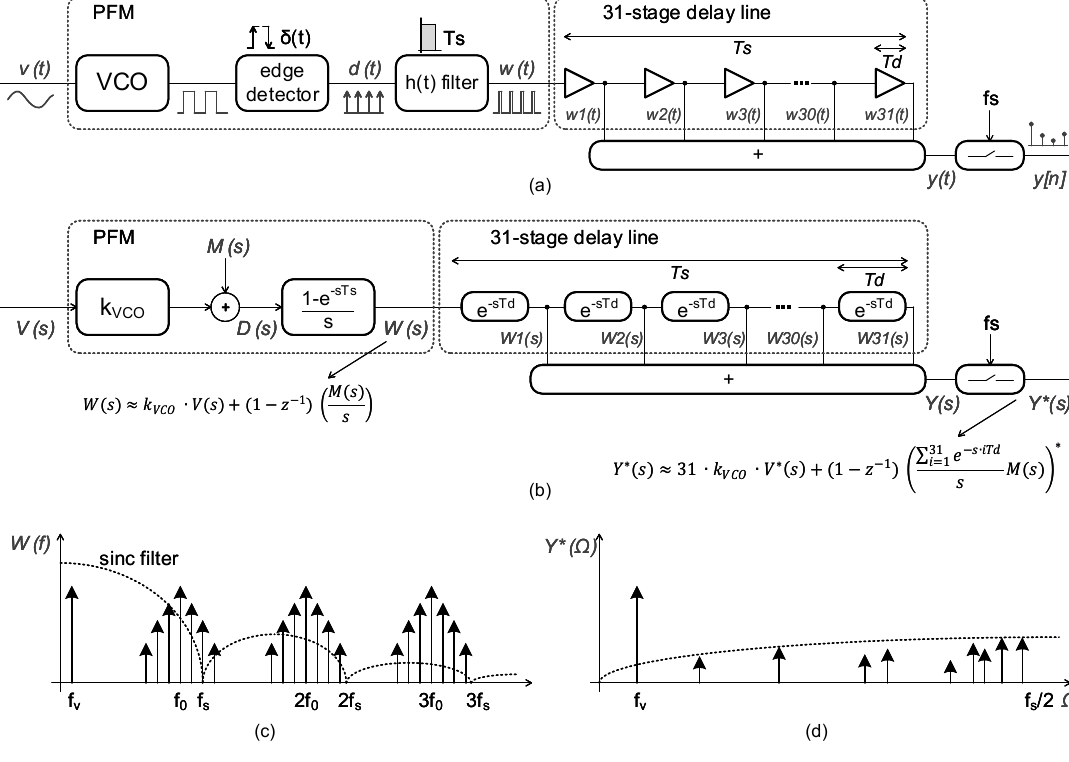
Figure 3. Pulse frequency modulation VCO-ADC: ( a ) Time model; ( b ) Laplace model; ( c ) filtered signal w ( t ) ; ( d ) sampled output y [ n ] .